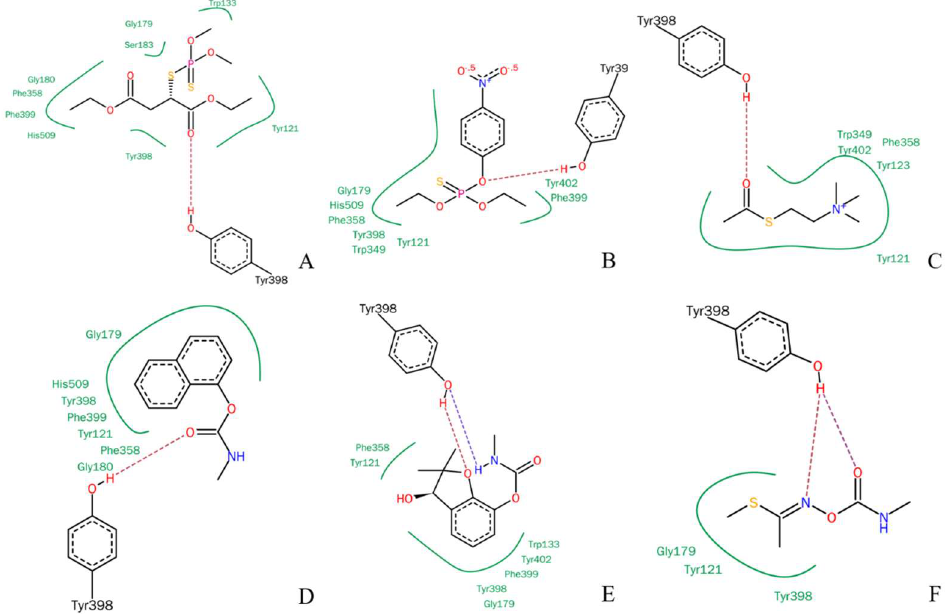
Figure 2. Planar schematic representation of the LeadIT solutions for pesticides in the active site pocket of r Bm AChE II. ( A ) Malathion, ( B ) parathion, ( C ) ATChI, ( D ) carbaryl, ( E ) Carbofuran-3-hydroxy, and ( F ) methomyl.